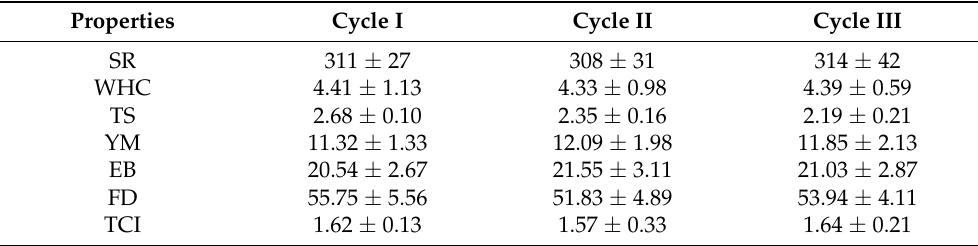
Table 3. Selected properties of BC pellicles synthesized by K. xylinus .